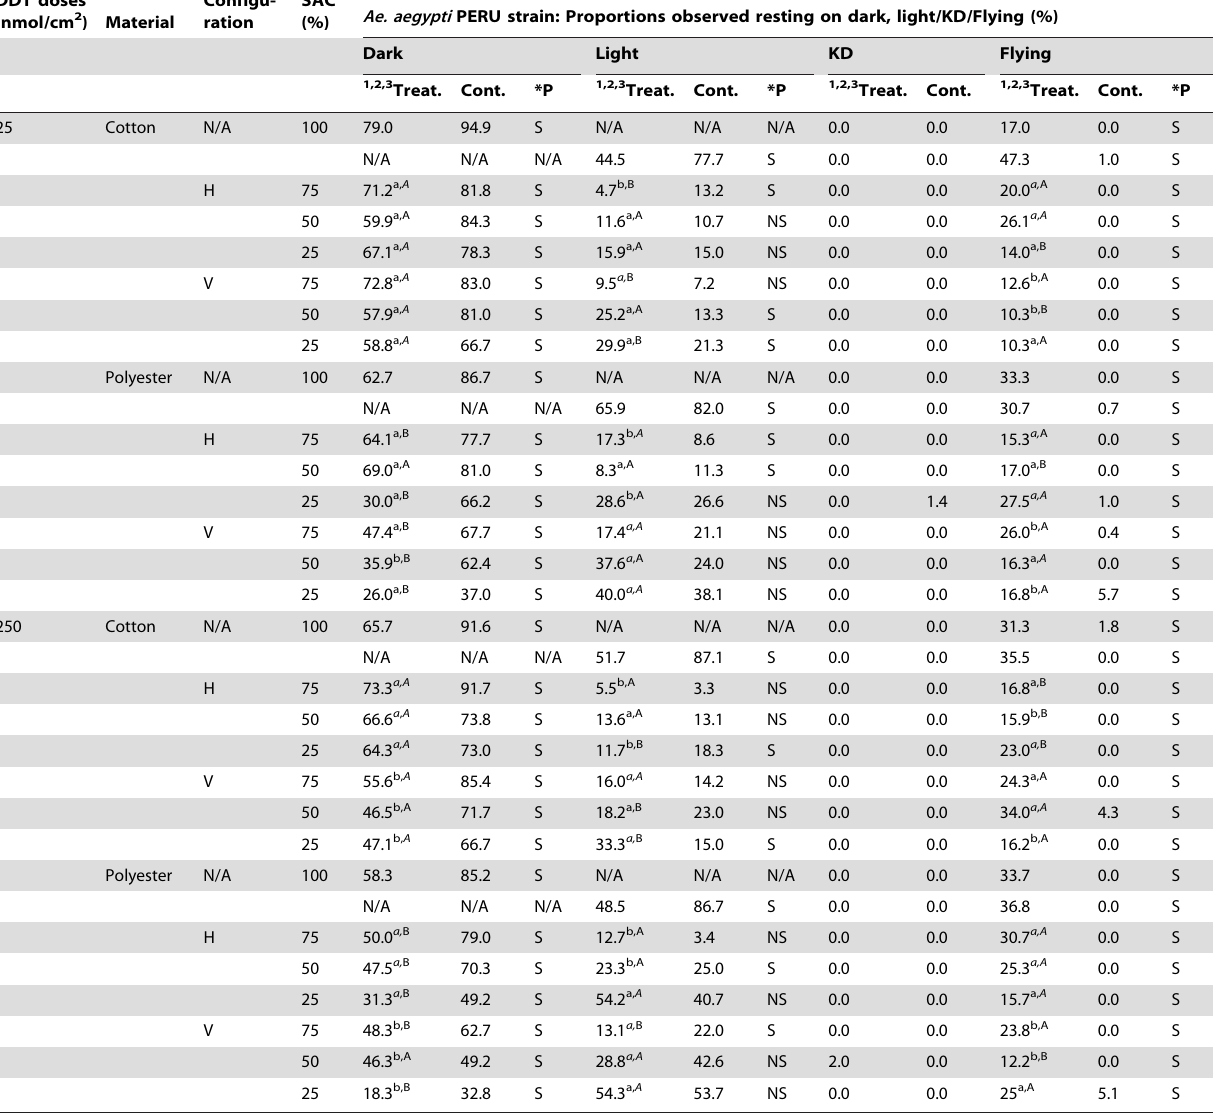
DDT doses (nmol/cm 2 )